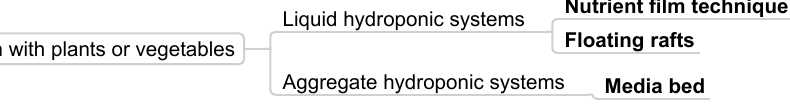
Figure 8. Partial taxonomy: Integration with